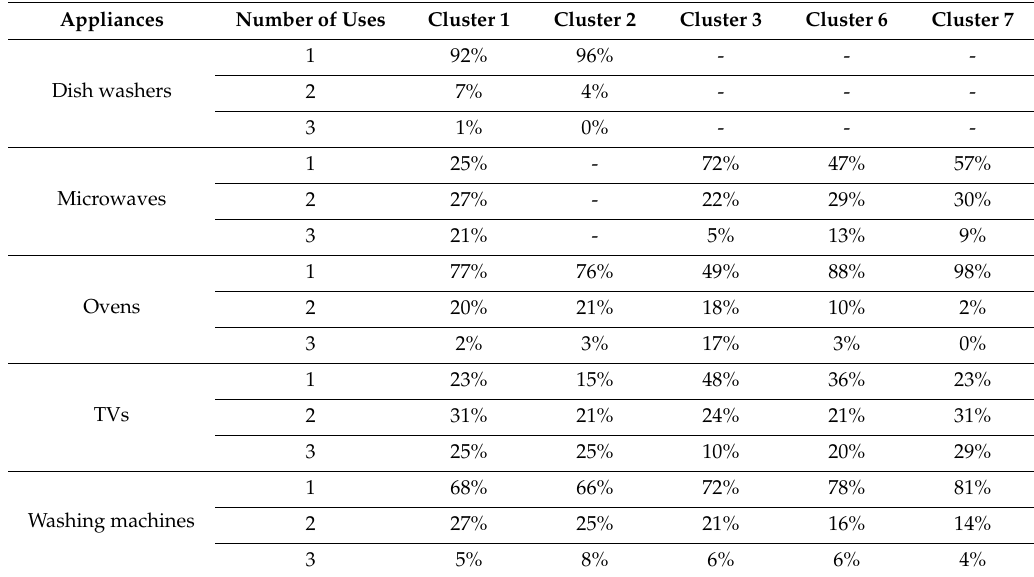
Table 9. Probability of usage during the day: Monitoring campaign results.